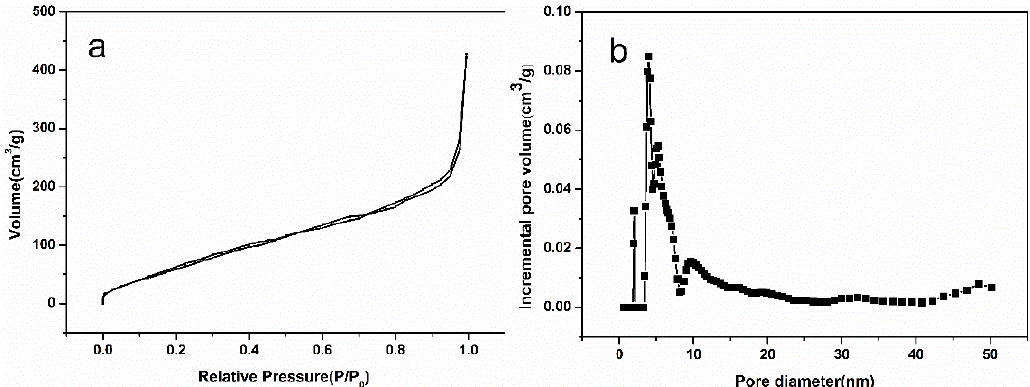
Figure 3. N 2 adsorption-desorption isotherms and the pore size distribution: ( a ) N 2 adsorption–desorption isotherms and ( b ) the pore size distribution.